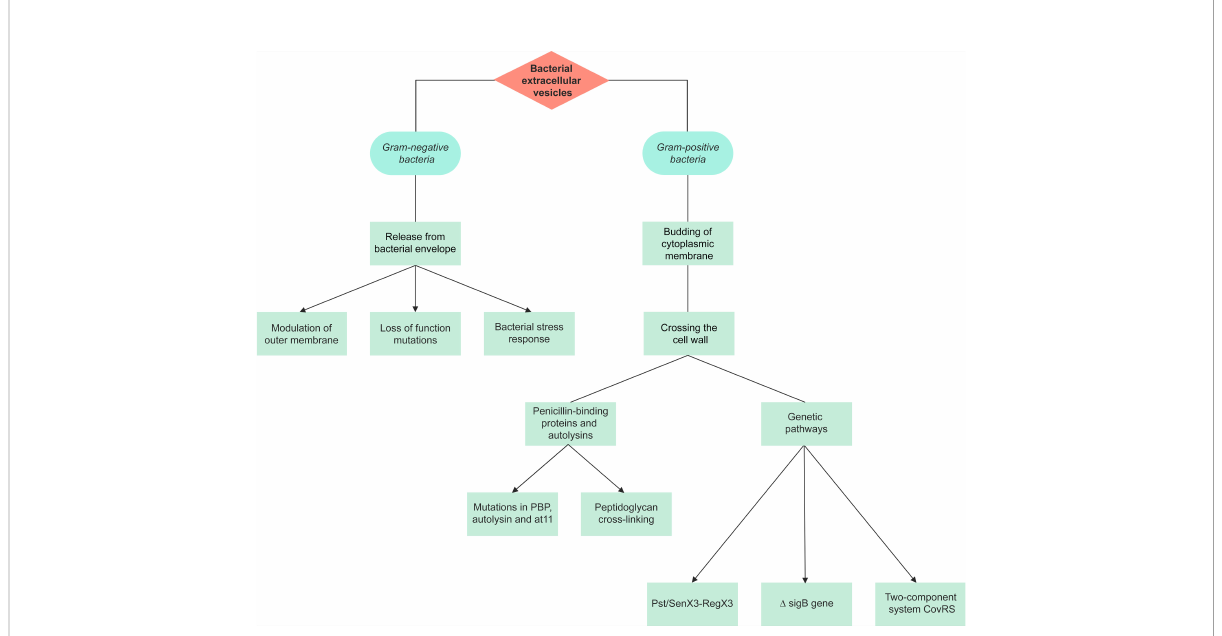
FIGURE 1 A summary of the pathways of extracellular vesicle biogenesis for Gram-negative and Gram-positive bacteria. The production of extracellular vesicles differs between Gram-negative and Gram-positive bacteria due to their different structures. There are 3 proposed models for the production of Gram-negative outer membrane vesicles, with the initial stage involving release from the bacterial envelope. Gram-positive bacteria lack an outer membrane, hence vesicles are formed through the budding of the cytoplasmic membrane and crossing of the cell wall. Gram-positive extracellular vesicles are synthesized either through penicillin-binding proteins and autolysins or genetic